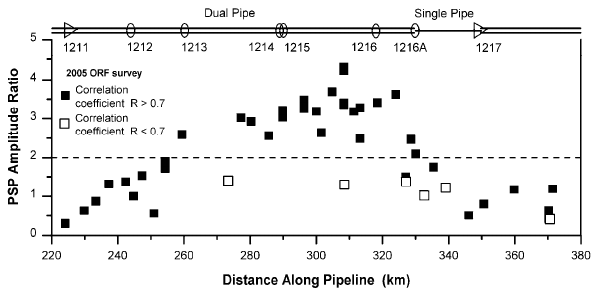
Fig. 5. PSP amplitude ratios (squares) as a function of the distance Figure 5. along pipeline and schematic representation of the pipeline structure (oval represents a main line valve; triangle represents a compressor station). Ratios above the dashed line are considered anomalously large (ratio > 2). Distance along pipeline is measured from kilome- ter point 0 in North